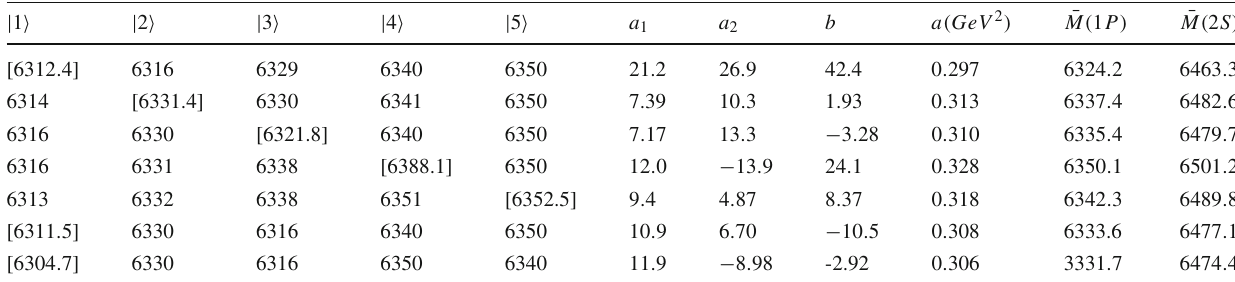
Table 6 Parameters and spin-averaged masses(in MeV) for the selected permutations of J P assignments of the four excited Ω b lev- els, with predicted mass at unseen level(marked by square bracket). All arrangements leading to highly unreasonable or unacceptable parameters are not listed. The shown includes also ensuing pre-